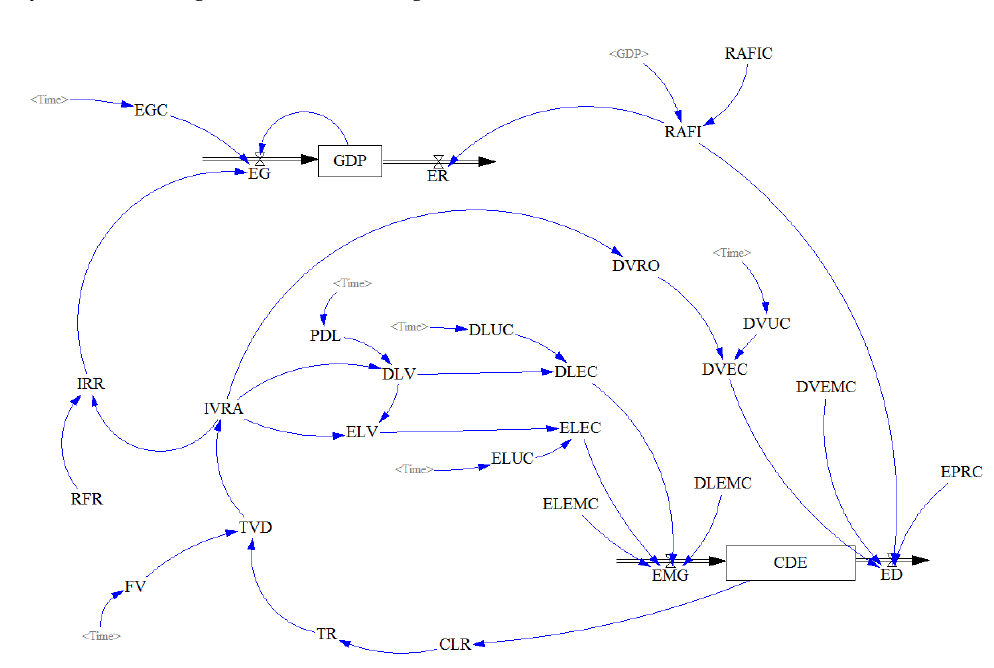
Figure 3. System flow diagram.